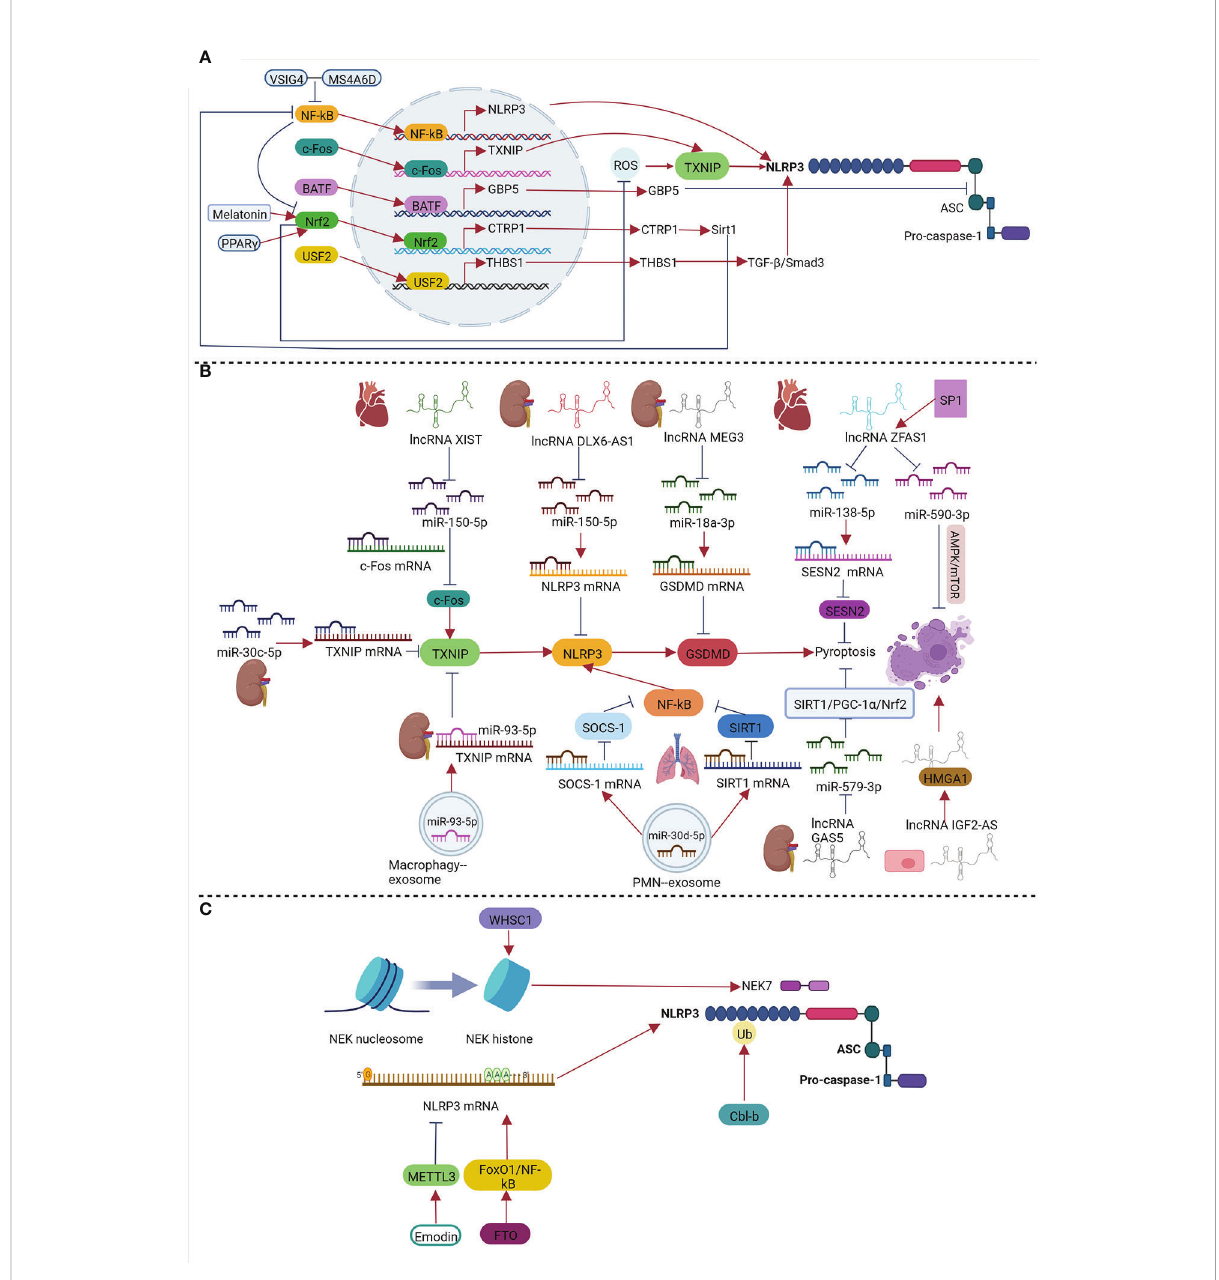
FIGURE 3 Regulation of pyroptosis under sepsis by transcription factors (A) , non-coding RNAs (B) , epigenetic modi fi cations and PTMs (C)